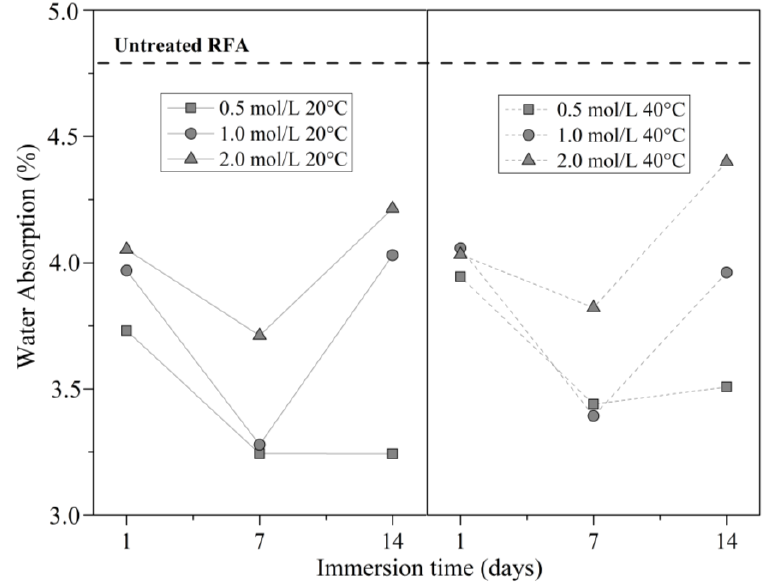
Figure 6. Water absorption (%) of the RFA treated with DAP solution.